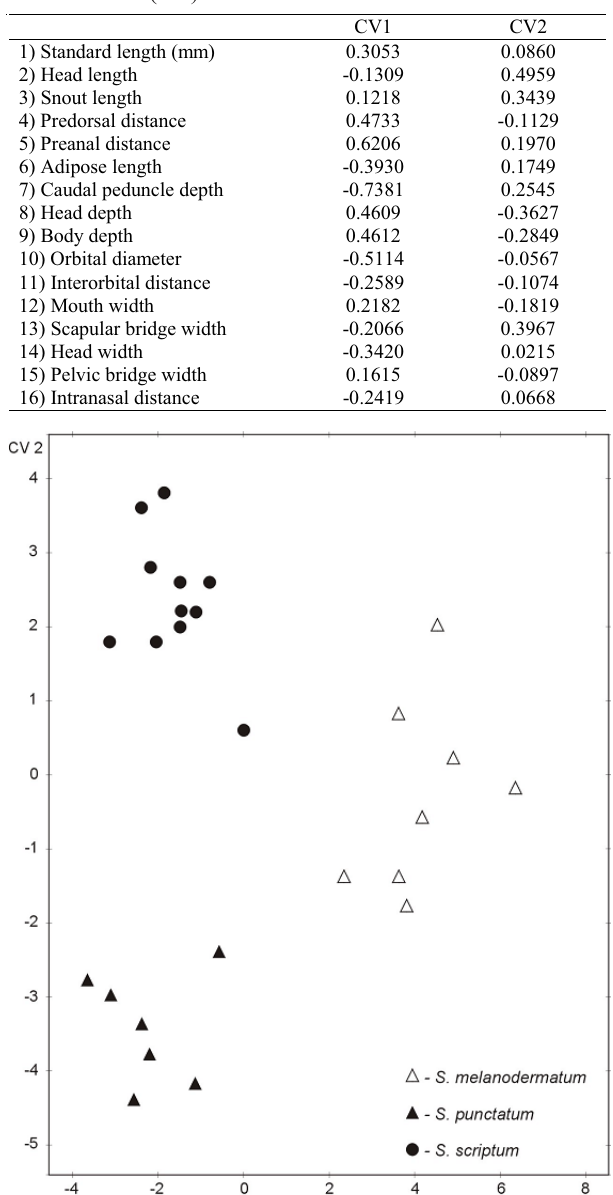
Table 3. Coefficients of the original variables in the two first canonical axis (CV).